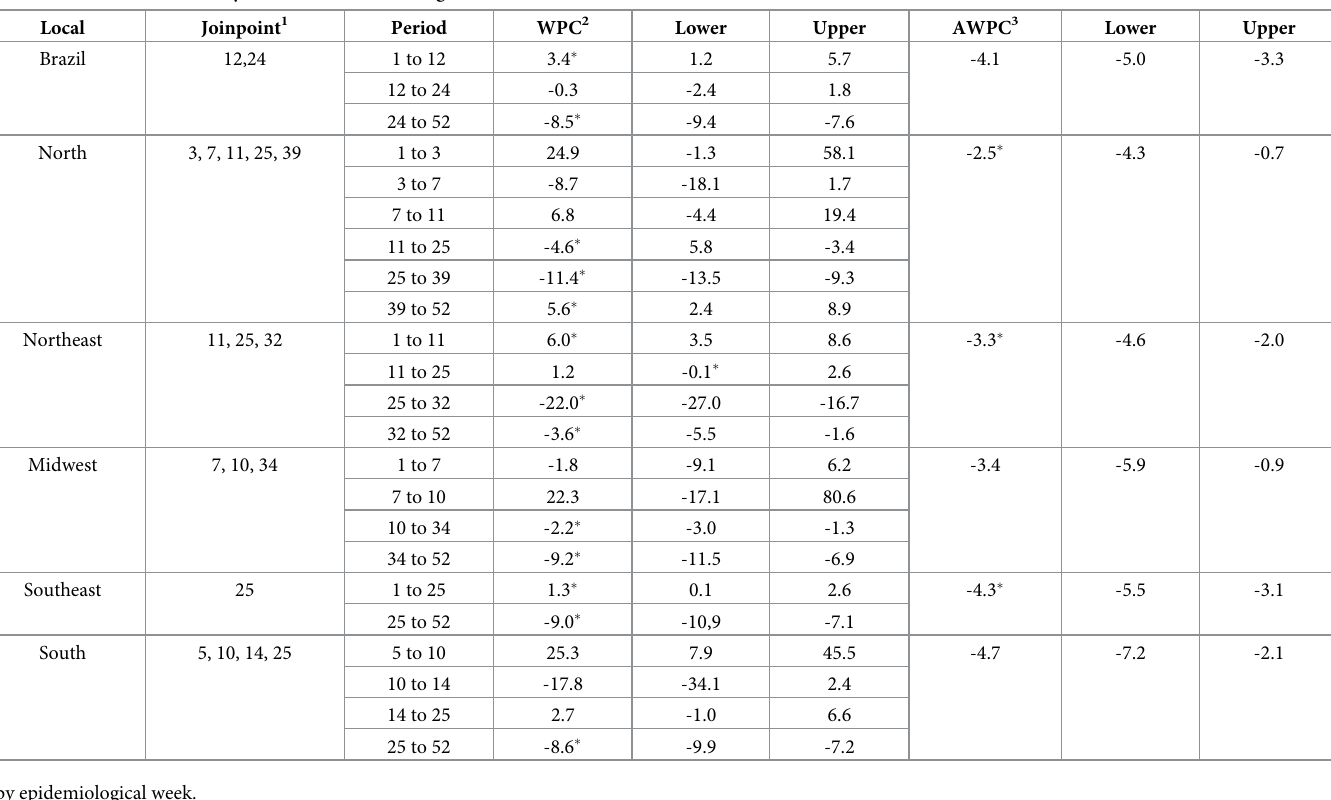
week percentage change. 3 average